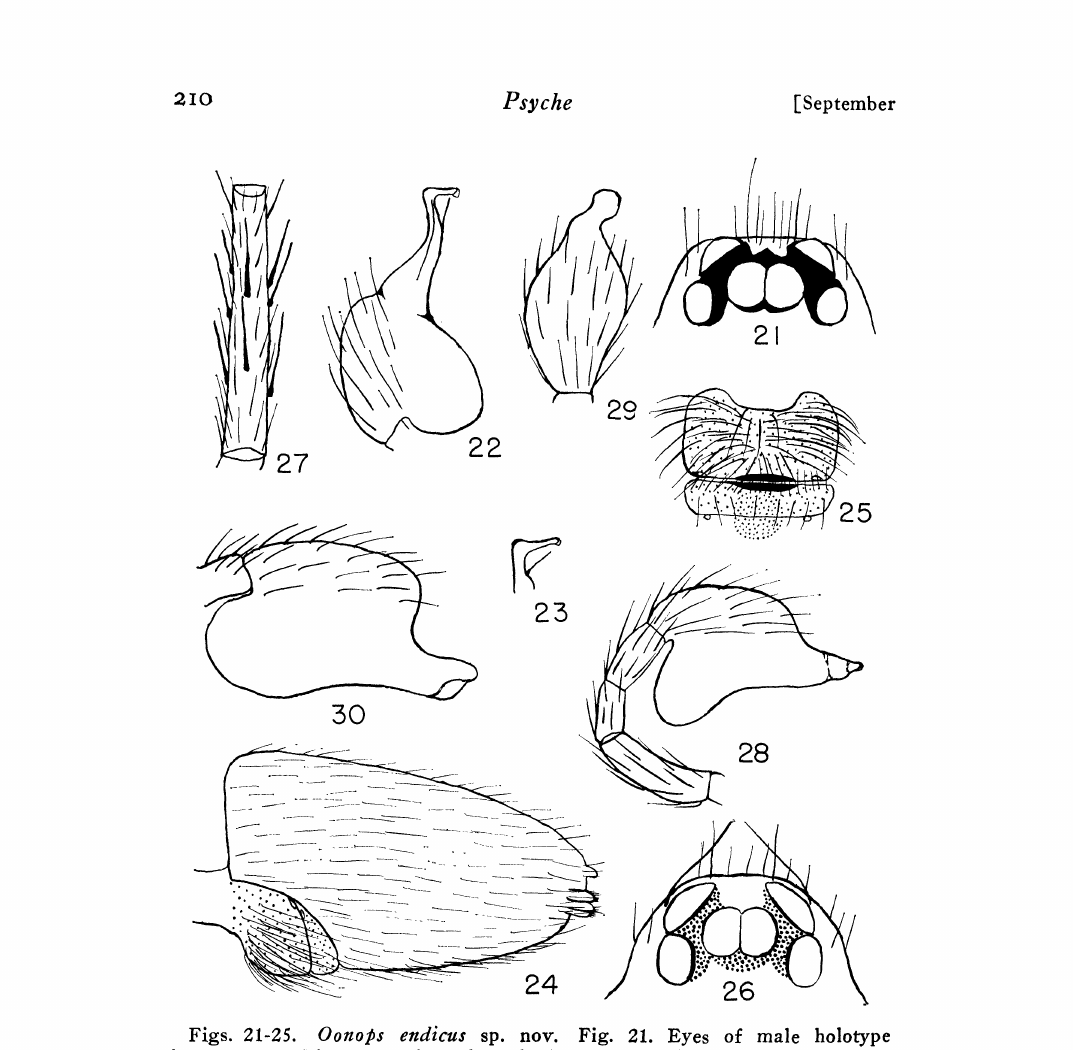
Figs. 21-25. Oonops endicus sp. nov. Fig. 21. Eyes of male holotype from above. Fig. 22. Left male palpal tarsus; prolateral view. Fig. 23. Tip of left embolus; slightly different view. Fig. 2. Abdomen of described female paratype; left lateral view. Fig. 25. Epigynal area of described female paratype. Figs. 26-30’. Oonops gertschi sp. nov. Fig. 26. Eyes of male holotype from above. Fig. 27. Right fourth tibia of paratype male; c[orsal view. Fig. 28. Left palp of holotype; prolateral view. Fig. 29. Left palpal tarsus of holotype; dorsal view. Fig. 30. Right palpal tarsus; retrolateral